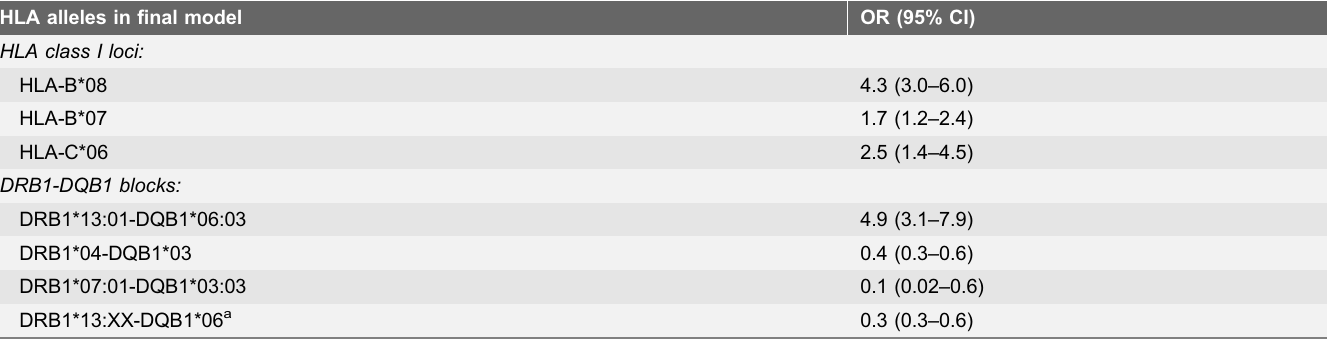
Table 1. Unconditional, multivariate logistic regression modeling incorporating all detected alleles from sequencing-based classical HLA typing at six